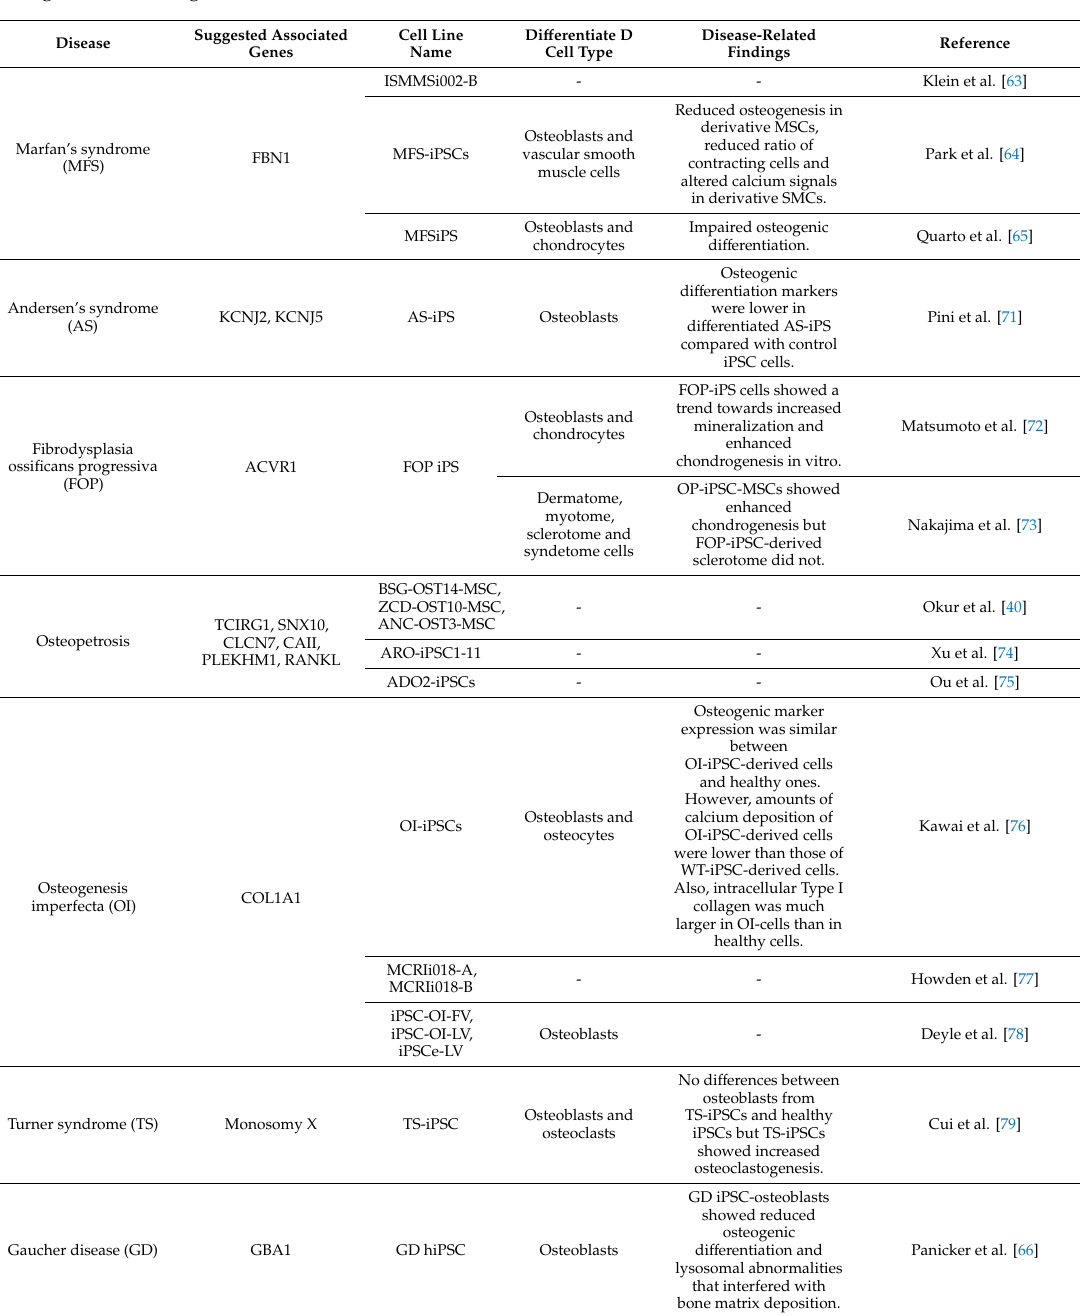
Table 1. Summary of disease models of bone, cartilage, nucleus pulposus and muscle disorders generated using